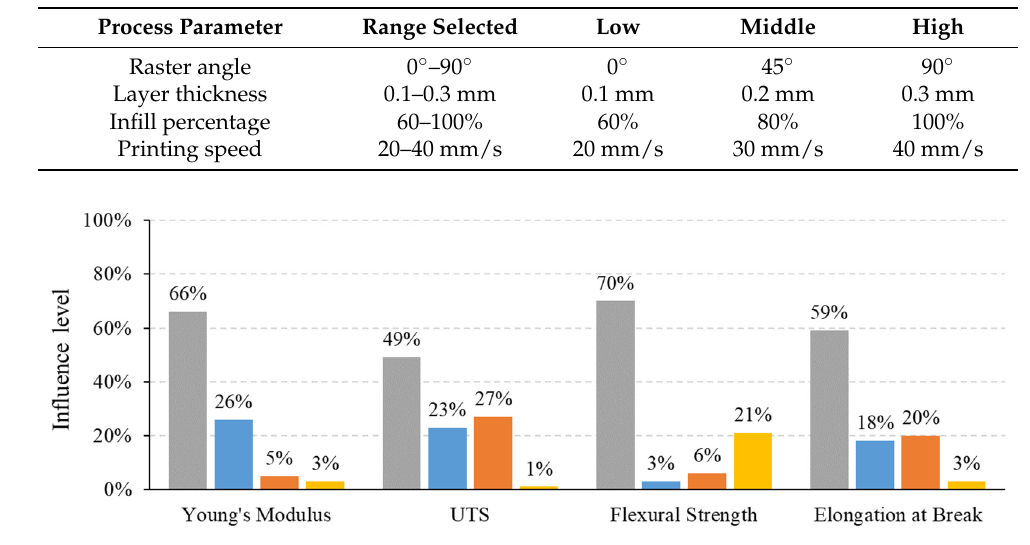
Table 4. Process parameters range used for ABS along with the related settings.